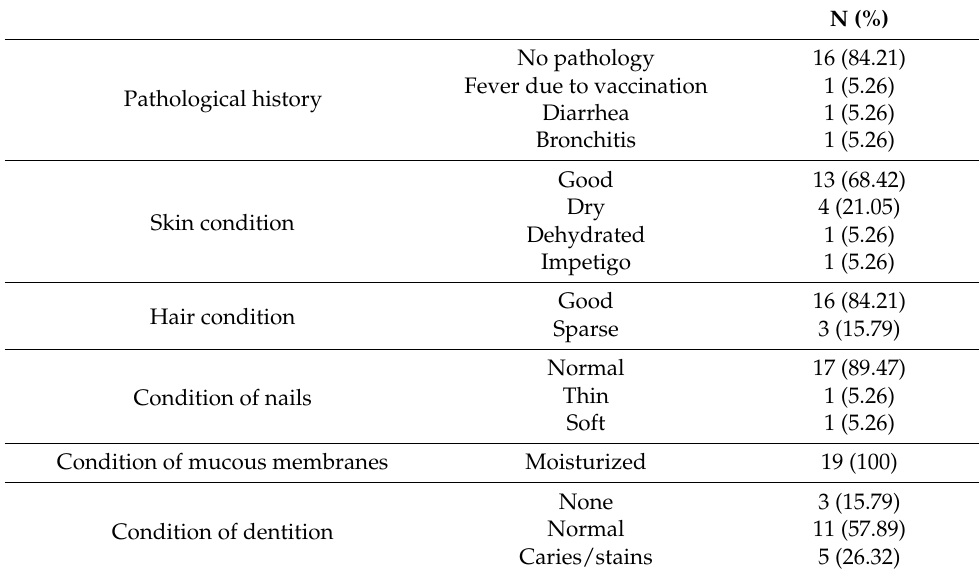
Table 3. Clinical-nutritional aspects of the children in the